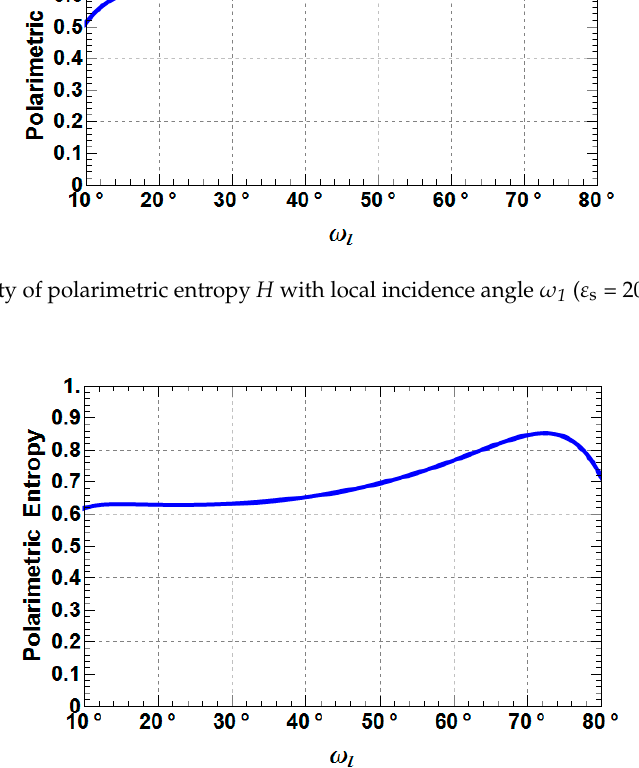
Figure 11. Sensitivity of polarimetric mean scattering alpha angle α with local incidence angle ω 1 ( ε s = 20, ε t = 10, L SXD = 1, ϕ = 0°, θ 1 = 30°).